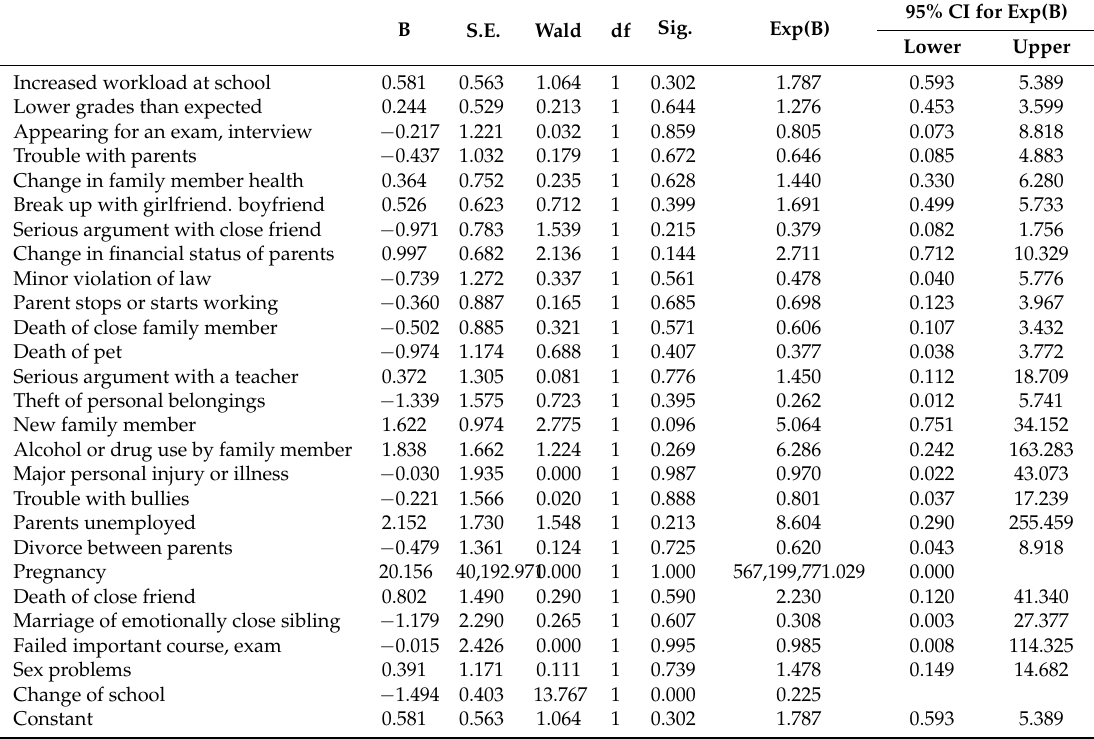
Table 5. D-SIB and individual life events in vocational school students.